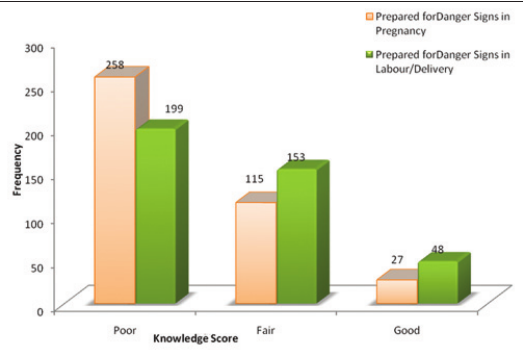
Figure 1 . Respondents’ Knowledge of Key Danger Signs.